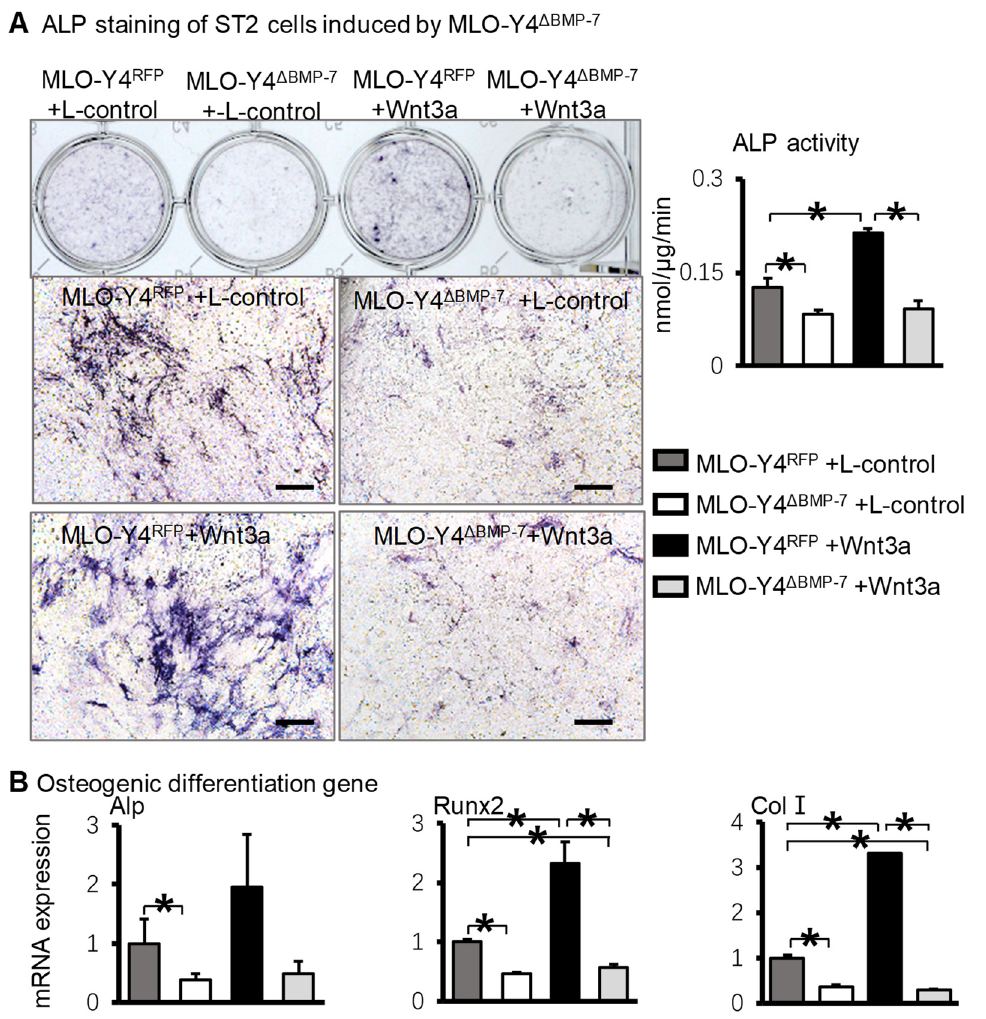
Figure 7. The osteogenic differentiation of ST2 cells when cocultured with BMP-7-silenced MLO-Y4 cells, which were pretreated Wnt3a. ( A ). ALP staining and quantitative analysis of ALP activity in the coculture of ST2 cells and BMP-7-silenced MLO-Y4 cells treated with Wnt3a. ( B ). The osteogenic gene changes in the coculture of ST2 cells and BMP-7-silenced MLO-Y4 cells treated with Wnt3a based on RT-qPCR. * p < 0.05, compared with the specified group. Scale bar: 50 µ